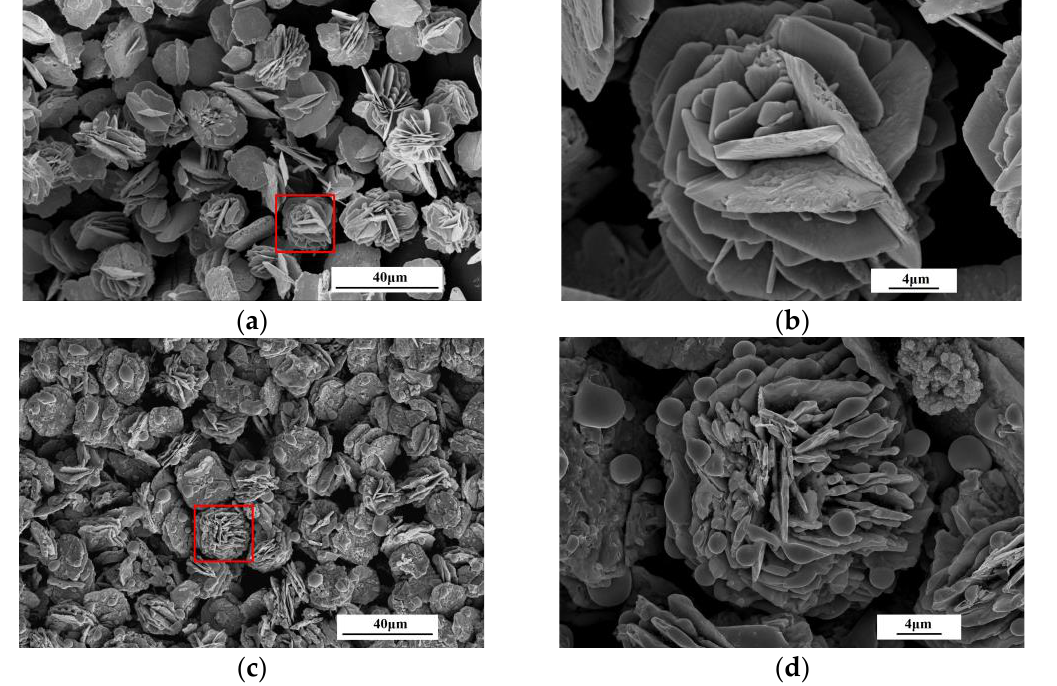
Figure 6. FESEM images of microstructure of ( a , b ) SnO precursor, ( c , d ) Sn/SnO 2 sample.